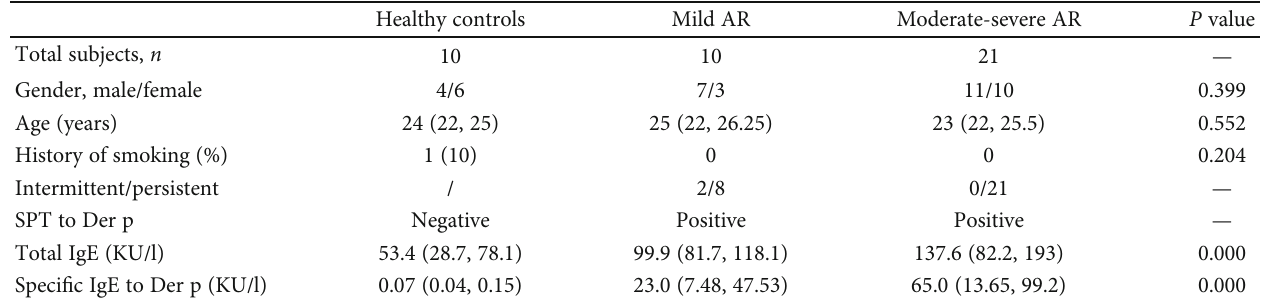
Table 3: Demographic summary of subjects in the cohort study. Healthy